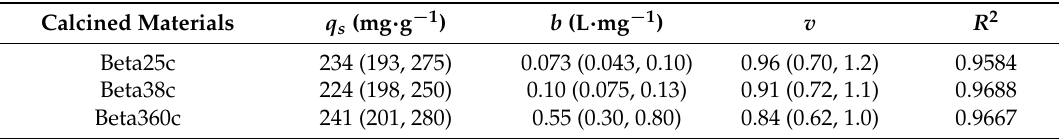
Table 3. Isotherm parameters for the adsorption of TOL on calcined BEAs estimated by non-linear fitting, according to the Tóth model. The confidence limits at 95% of probability of the estimated parameters are reported in